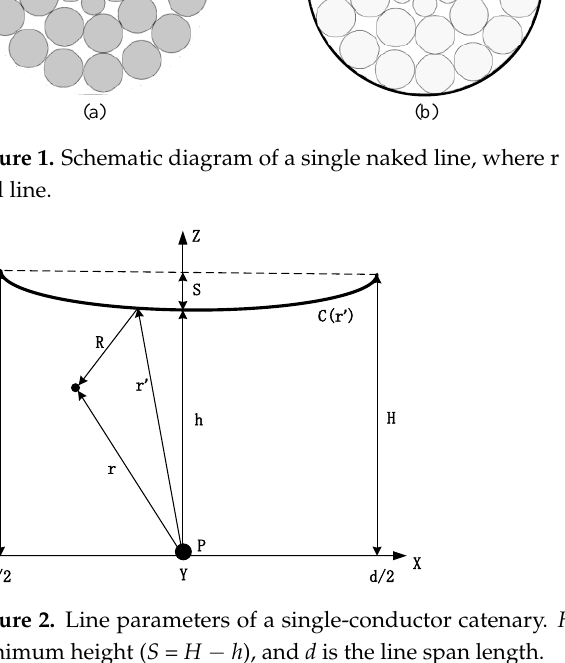
Figure 2. Line parameters of a single-conductor catenary. H is the maximum line height, h is the minimum height ( S = H − h ), and d is the line span length.